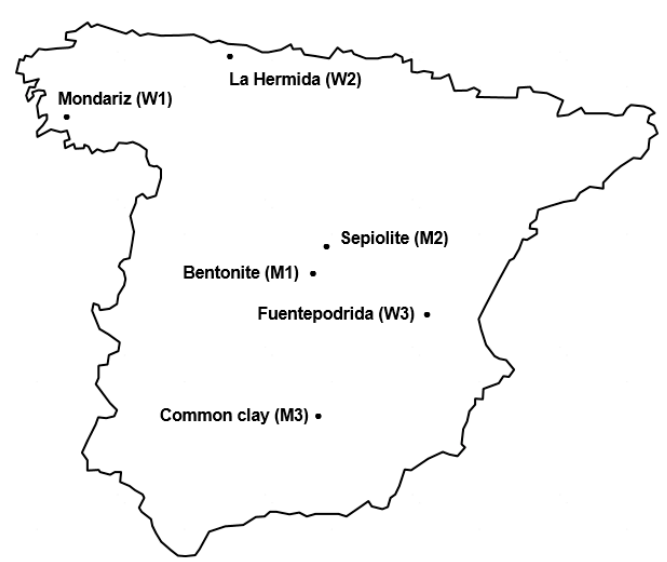
Figure 1. The geographical locations of the clays and mineral-medicinal waters in Spain.